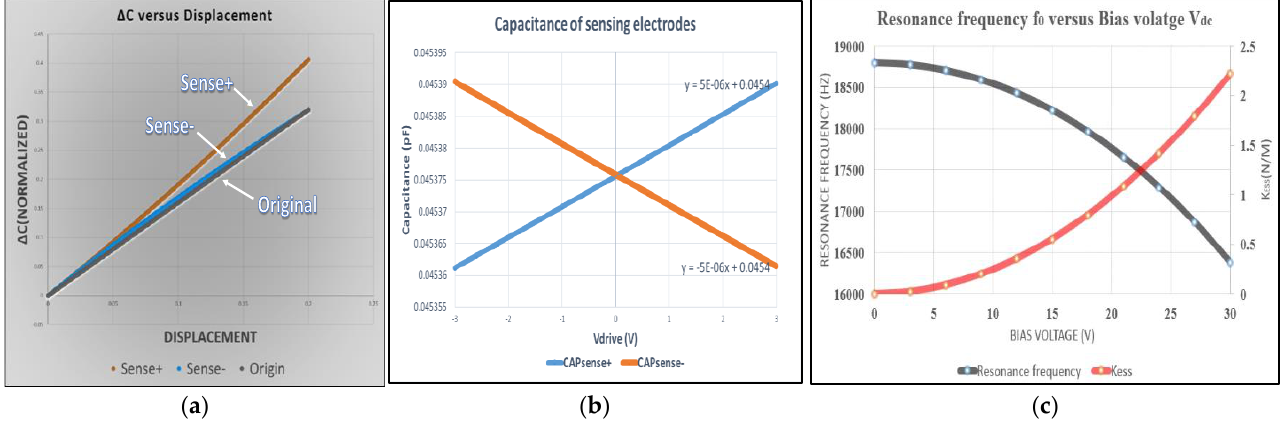
Figure 8. ( a ) Normalized variant capacitance versus displacement of MEMS structure; ( b ) capacitance versus driving voltage of the proposed structure; ( c ) resonance frequency and electrostatic stiffness versus bias voltage.